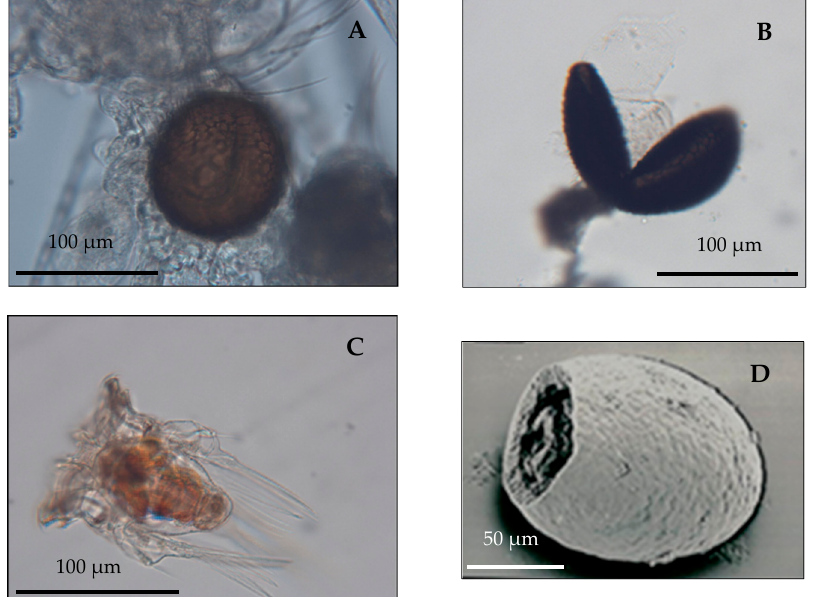
Figure 3. ( A ) Hexarthra bulgarica nepalensis from a plankton sample of LCN70 carrying a diapausing egg; ( B ) Hatching of a diapausing egg of Hexarthra bulgarica nepalensis recovered from sediment core LCN70 94/2; ( C ) Newborn of Hexarthra bulgarica nepalensis hatched from the diapausing egg; ( D ) SEM image of a Brachionus sp. open egg case recovered from sediment core LCN70 94/2.